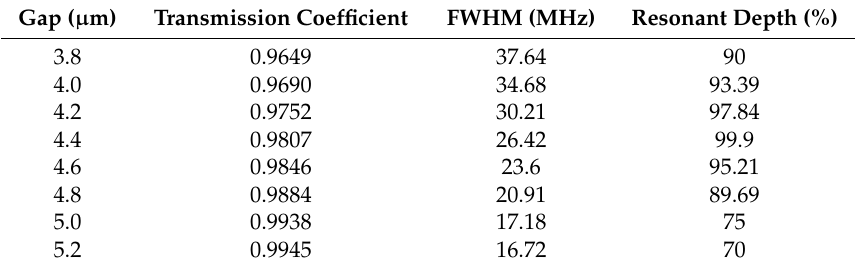
Figure 3. ( a ) Designed silica waveguide resonator; ( b ) test system used to measure the Q actor and the resonant depth; ( c ) test results for resonator with a 4.8 µ m gap; ( d ) scanning electron microscope (SEM) image of waveguide cross-section; ( e ) coupling region viewed under confocal microscope. Table 1. Transmission coefficient, full width at half maximum and resonant depth obtained by the simulation.